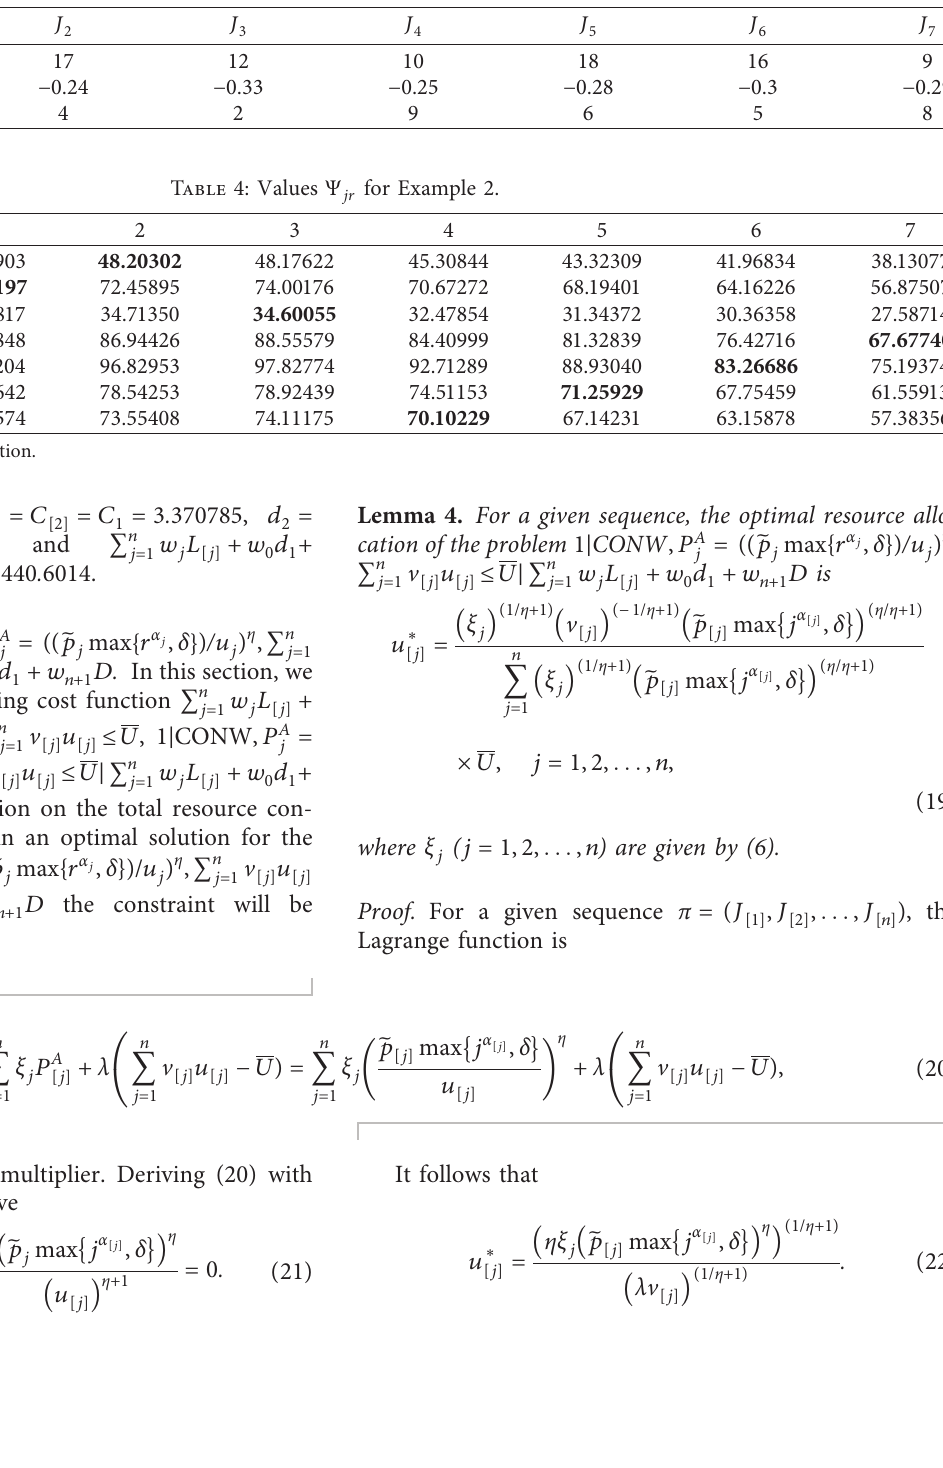
Table 3: Data for Example 2.